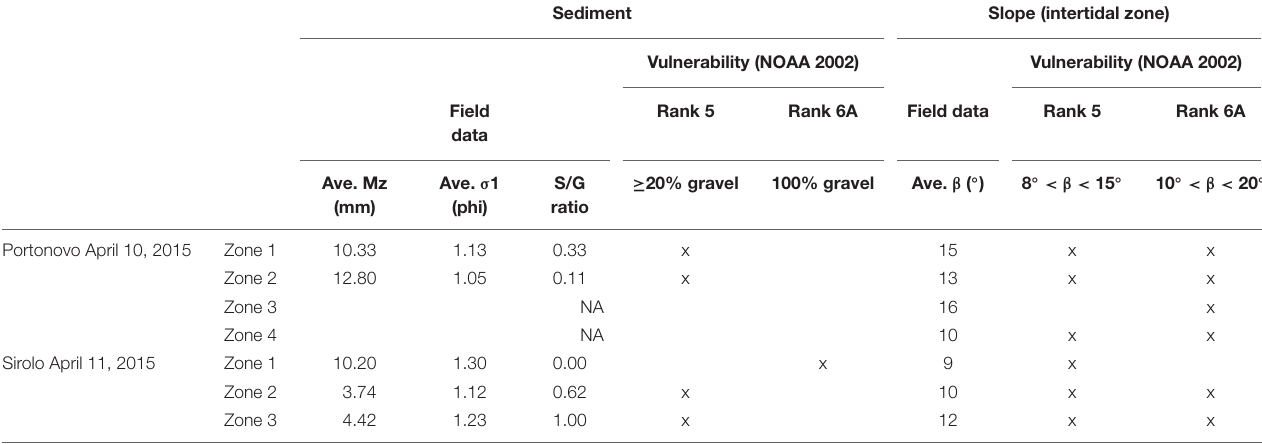
TABLE 2 | The National Oceanic and Atmospheric Administration [NOAA] (2002) classification for Portonovo and Sirolo according to field data of April 2015.